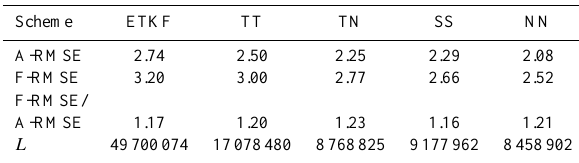
Table 1. The time-mean values of A-RMSE and F-RMSE, the ratio of F-RMSE to A-RMSE, and the objective function (second-order distance from the squared innovation statistic to its expectation) in the five ETKF methods for the Lorenz 96 model, with forcing parameter F = 12 and parameter of observation operator α = 0 . 1. ETKF: traditional ETKF in linear approximation (Eq. 12) and op- timization (Eq. 10); TT: tangent-linear approximation in both in- flation (Eq. 17) and optimization (Eq. 20); TN: tangent-linear ap- proximation in inflation (Eq. 17) and nonlinearity in optimization (Eq. 10); SS: second-order Taylor approximation in both inflation (Eq. 24) and optimization (Eq. 27); NN: nonlinearity in both infla- tion (Eq. 5) and optimization (Eq. 10).